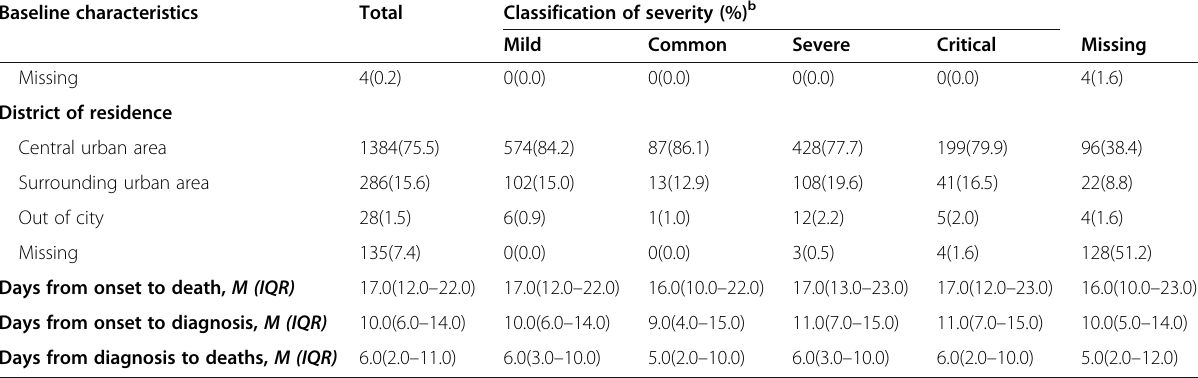
Table 1 The epidemiological characteristics of deceased patients of COVID-19 infection with different severities in Wuhan during the early stage (Continued)